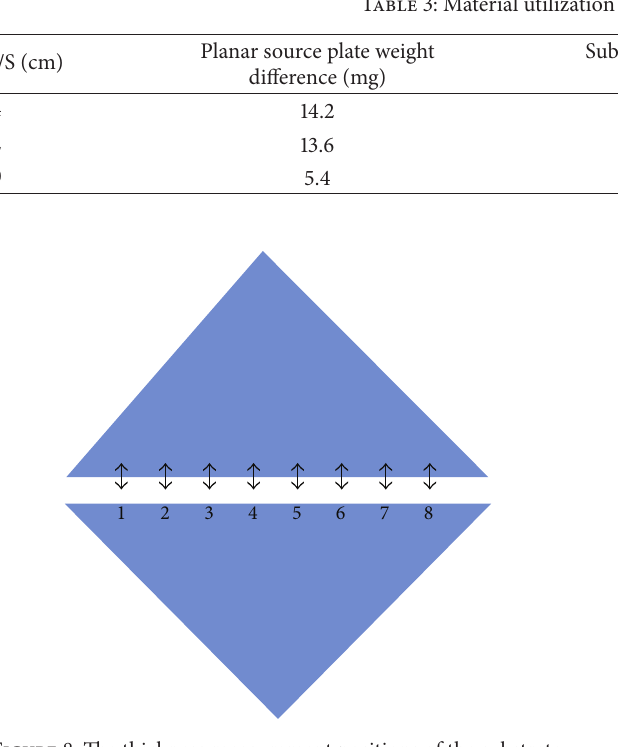
Figure 8: The thickness measurement positions of the